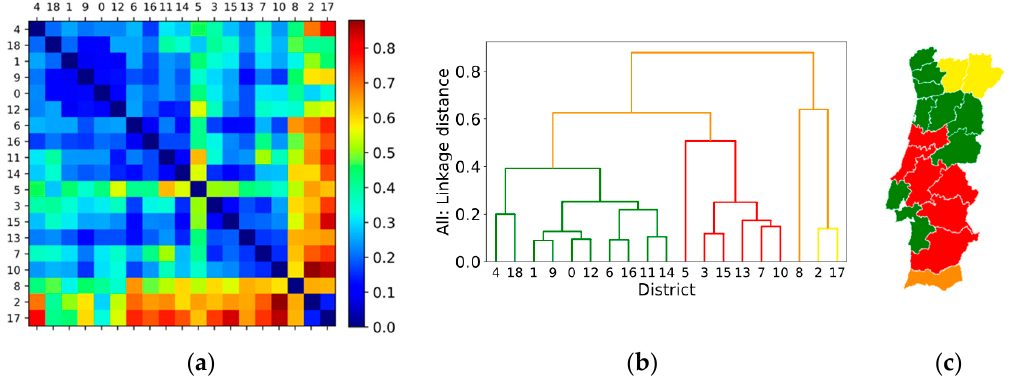
Figure 8. Ability to respond to requests: ( a ) Dissimilarity matrix based on Spearman correlation coefficient; ( b ) Clusters by annual profile distribution of TIF in relation to TF; ( c ) Clusters in geographic location (cophenetic coefficient: 0.76).